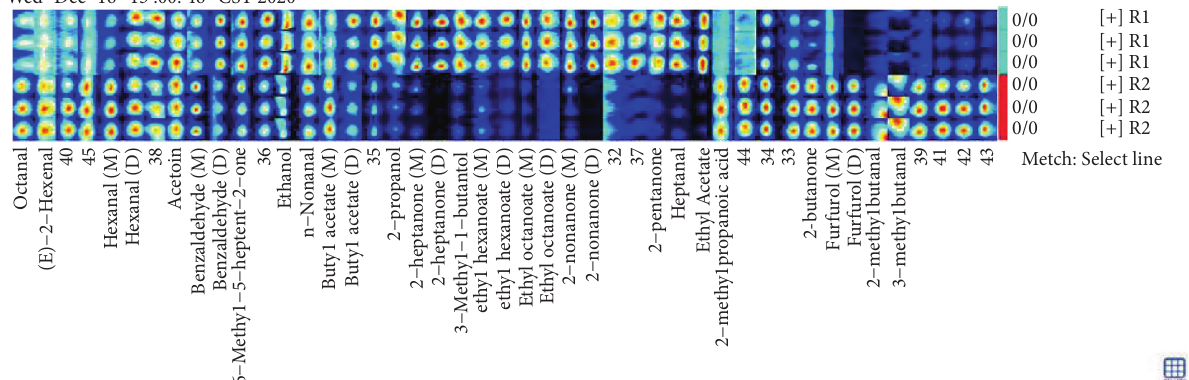
Figure 3: Gallery plot of the differential signal affected by the temperature. R 1 refers to samples at − 20 ° C. R 2 refers to samples at 28 ° C. The darker the color, the higher the content of volatile organic compounds.